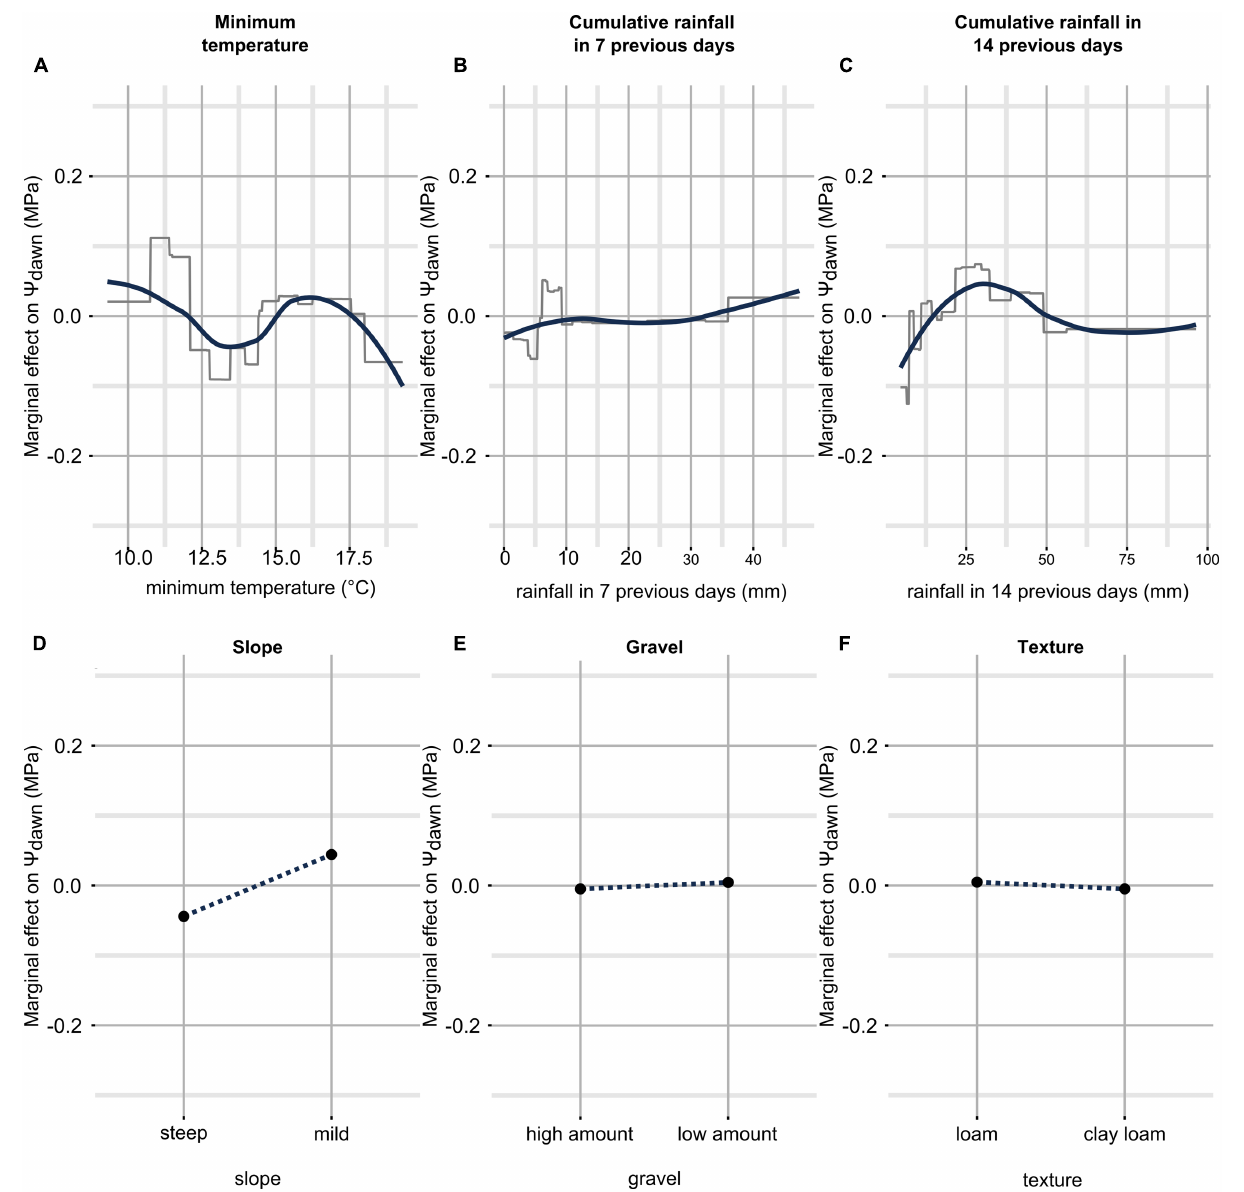
FIGURE 7 | Partial dependence plots for each predictor in the (cid:57) pd model. Only simple relationships (no interactions) are shown. They have been obtained by predicting (cid:57) pd while fixing all predictors to their mean value except the one in question, which was allowed to finely vary across the range of observed data. On the y axis there is the marginal effect on (cid:57) pd , i.e., when it has a 0 value, (cid:57) pd is estimated to its mean by the predictor in question, when it has a value different from 0, (cid:57) pd is estimated higher or lower than its mean by the corresponding value. On the x axis there is the range of observed data for the predictor in question. The essential relationships between predictor and outcome are captured in a smoothed fashion by the red line which is a loess applied to the partial prediction data. The gray lines are original functions as based on the trees used in the models. When the predictor is discrete (as for soil properties), the function shown in the partial dependence plots is also discrete and has a single value for each level of the predictor (soil properties are binary here, then two values). See text for detailed description. Plot (A–F) shows partial dependence plots between predictor and outcome: (A) for temperature, (B) for cumulative rainfall in 7 previous days, (C) for cumulative rainfall in 14 previous days, (D) for slope, (E) for gravel, (F) for